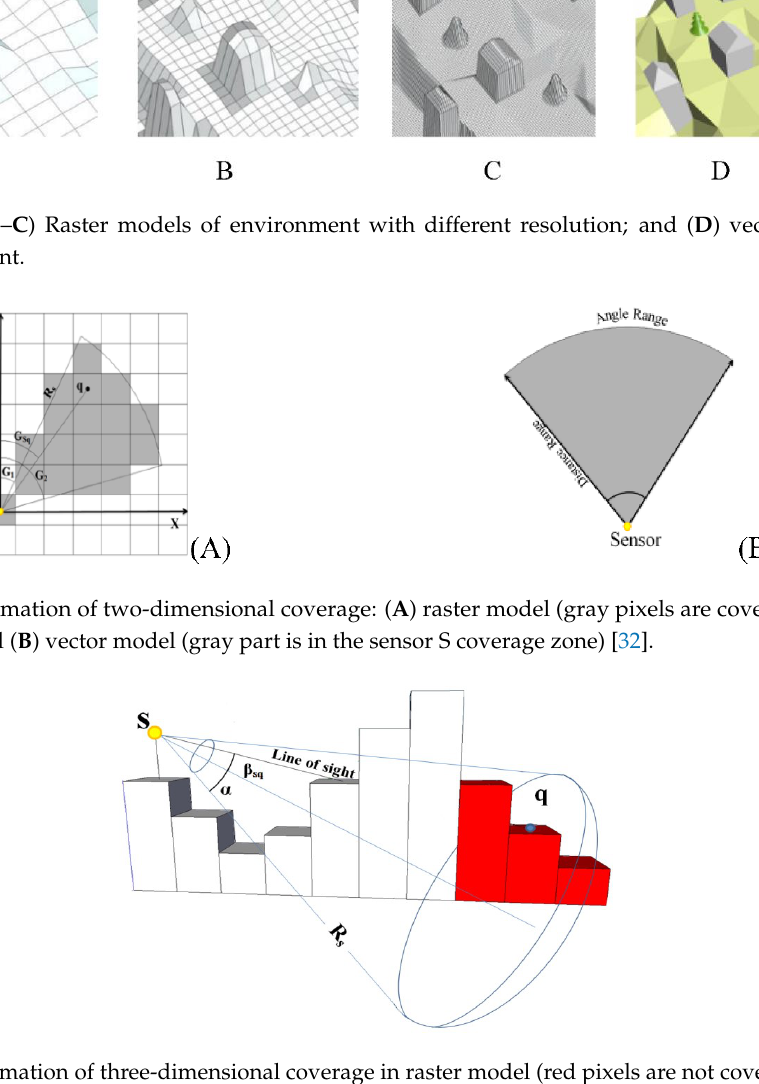
Figure 3. Estimation of three-dimensional coverage in raster model (red pixels are not covered by the sensor S).